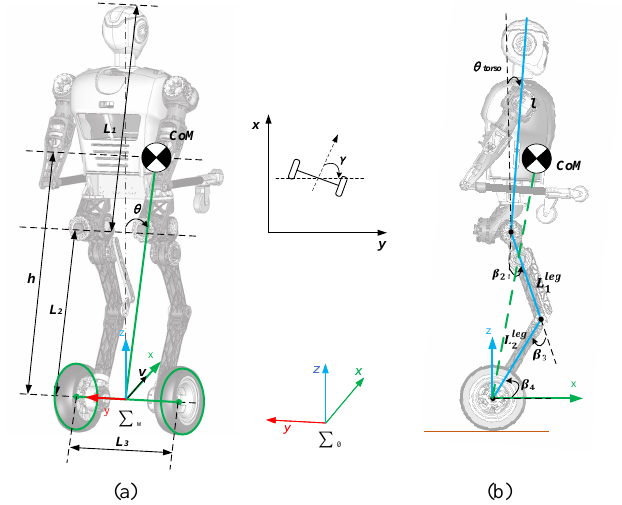
Figure 5. Generalized coordinates of the wheel-legged robot model: ( a ) The inverted pendulum model on wheels; ( b ) The simplified model of body